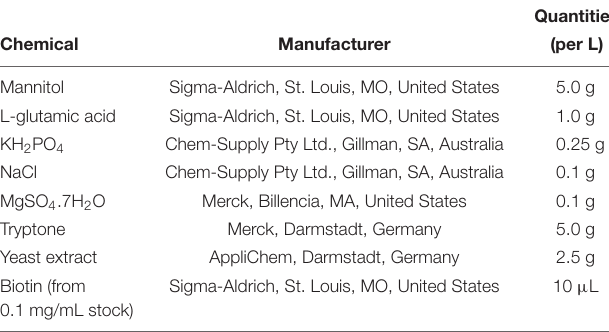
TABLE 1 | Ingredients for the preparation of bacterial MGL medium.